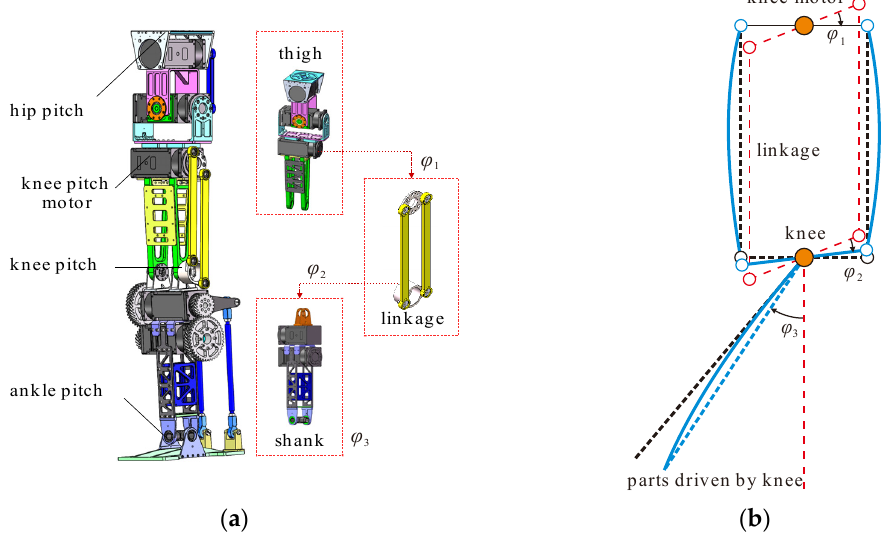
Figure 3. Leg structure of the biped robot AIRO: ( a ) Drive chain of the knee pitch motion; ( b ) Schematic representation of the knee pitch motion.